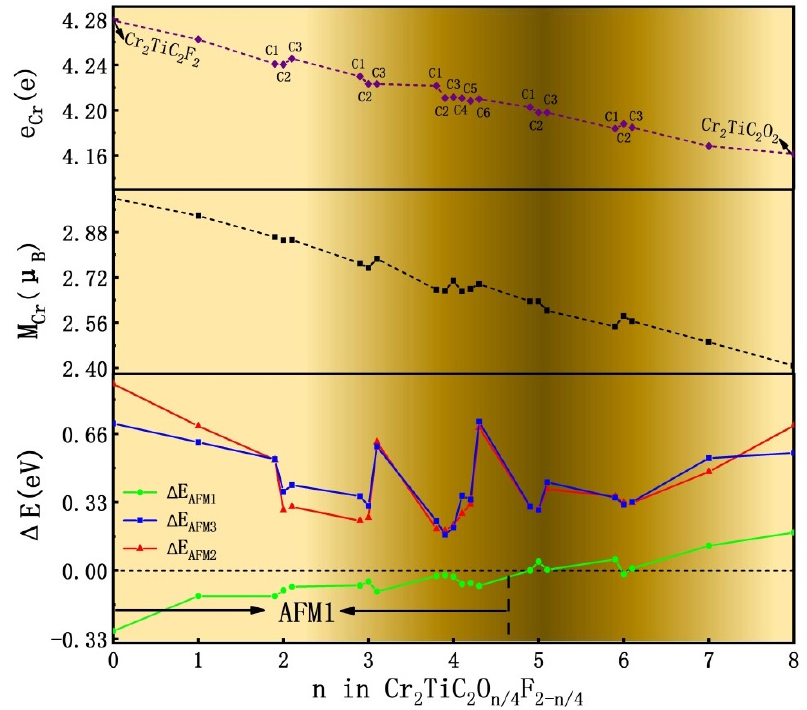
Figure 2. ( Top panel ) Distribution of the number of electrons of Cr atoms (e Cr ). ( Middle panel ) Distribution of the magnetic moment of Cr atoms (M Cr ). ( Down panel ) Energy difference of AFM1 ( Δ E AFM1 ), AFM2 ( Δ E AFM1 ), AFM3 ( Δ E AFM1 ) with FM state of the Cr 2 TiC 2 O n/4 F 2 − n/4 system.